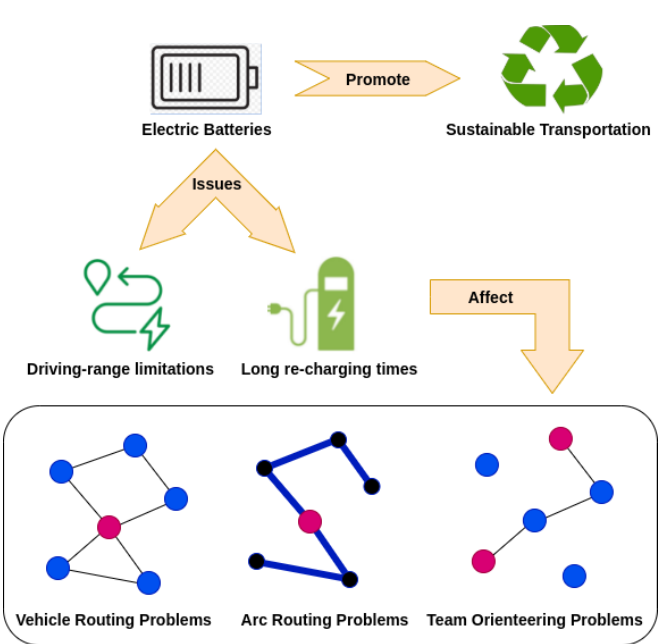
Figure 1. Conceptual schema of the topics discussed in this